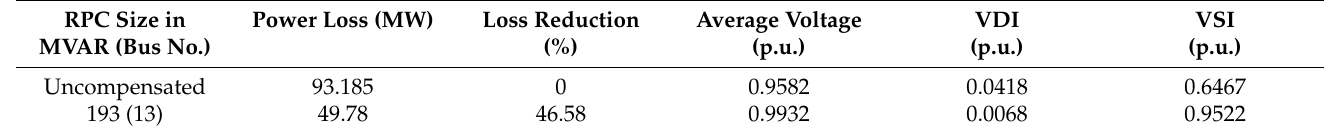
Table 3. Results for the RPC